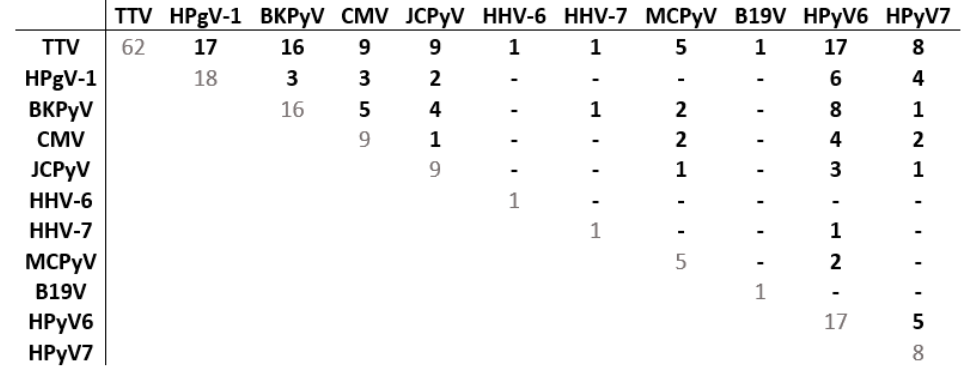
Figure 5. Matrix of dual co-detections among patients of group 3 at M3. The matrix represents dual co-detections among the 63 patients of group 3 (20 viral species screened) with at least one virus detected at M3. Each number represents the number of patients for whom the two viruses were detected (other viral species possibly co-detected are not shown). Abbreviations: CMV: cytomegalovirus; HHV-6: human herpes virus 6; HHV-7: human herpes virus 7; JCPyV: JC polyomavirus; BKPyV: BK polyomavirus; MCPyV: Merkel cell polyomavirus; HPyV6: human polyomavirus 6; HPyV7: human polyomavirus 7; B19V: parvovirus B19; TTV: torque teno virus; HPgV-1: human pegivirus 1.